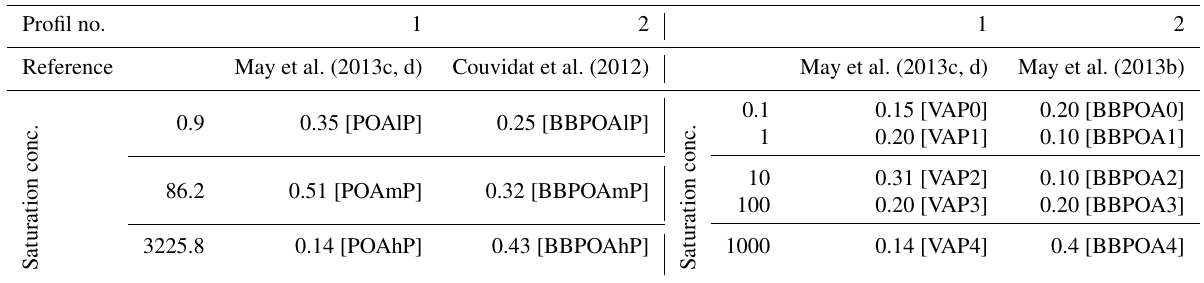
Table 2. Summary of the volatility distributions of the primary I/S-VOC surrogates. Saturation concentrations are expressed in µgm − 3 . For each saturation concentration and volatility coefficient, the name of the associated primary surrogate is in square brackets. Profil no.